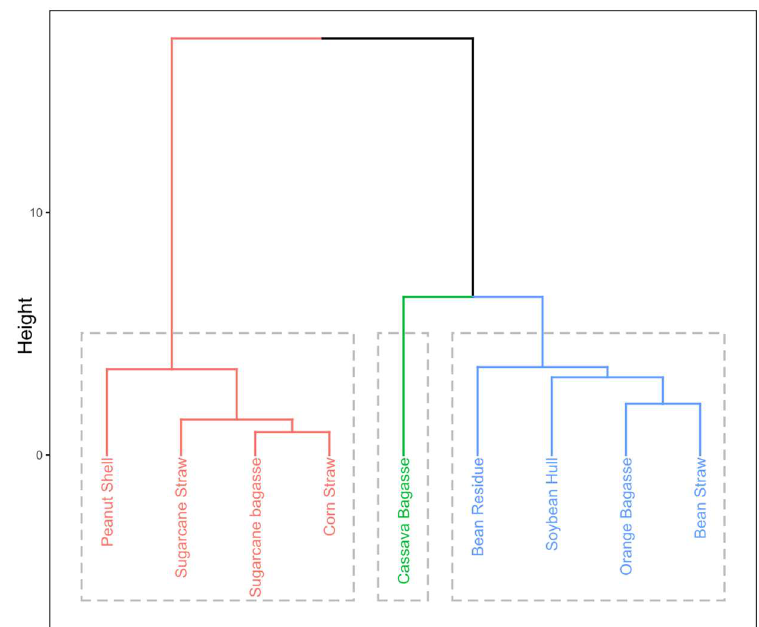
Figure 1. Multivariate cluster analysis plot showing groups of different by-products based on similarities in chemical composition, in vitro degradability, and fermentation parameters.